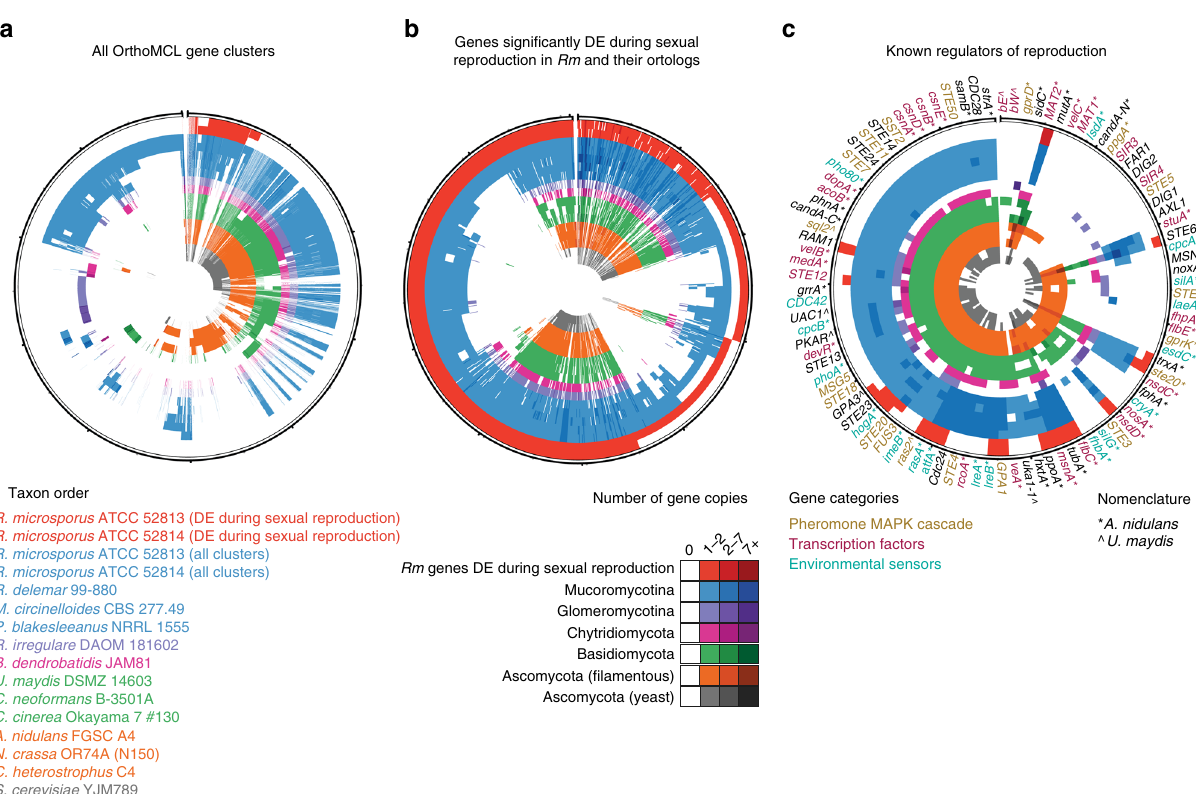
Fig. 2 Many genes differentially expressed during Rm sexual reproduction are unique to Mucoromycotina. Tracks show gene content (copy number) for each individual genome, and each column represents an individual OrthoMCL cluster. Counts of gene copies within an individual cluster are shown in increasingly darker shades of color: red, DE genes in Rm ; blue, Mucoromycotina; purple, Glomeromycotina; pink, Chytridiomycota; green, Basidiomycota; orange, fi lamentous Ascomycota; gray, Ascomycota yeasts. a All OrthoMCL gene clusters. b Genes DE during sexual reproduction of Rm . c Regulators of sexual reproduction. Gene names are colored based on what aspect of sexual reproduction they are involved in: mustard, pheromone MAPK cascade; purple, transcription factors; teal, environmental sensors. All data are presented in Supplementary Data 2, and are ordered based on Fig.